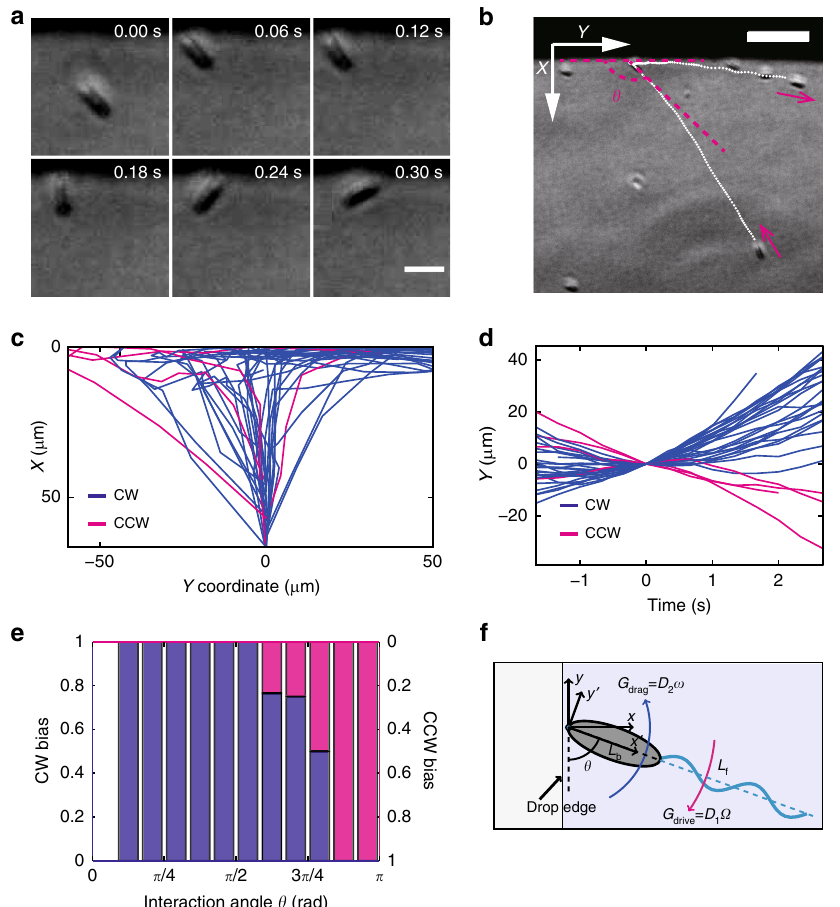
Fig. 3 Single-cell motion pattern of P. mirabilis near diluted colony edge. a A sequence of phase contrast images recording the CW turning of an isolated cell colliding with the diluted colony edge ( “ Methods ” ). The dark area in upper portion of images is virgin agar. Scale bar, 5 μ m. b Trajectory of the cell in panel a generated by overlaying a series of phase contrast images. Magenta arrows by the side of trajectory (white dotted line) indicate instantaneous moving direction of the cell. See Supplementary Movie 8. θ denotes interaction angle, de fi ned as the angle between the diluted colony edge and the cell orientation just before collision. Scale bar, 20 μ m. c Representative trajectories ( N = 31) of cells that collided with diluted colony edge. Following the coordinate system speci fi ed in panel b , X = 0 μ m is set at the edge of liquid drops. The starting point of all trajectories are aligned and set as Y = 0 μ m and X = 55 μ m. Blue (or magenta) lines represent the trajectory of cells that turned CW (or CCW) around the contact point during collision. d Tangential position of cells (whose trajectories were shown in panel e ) plotted against time. The collision positions of all trajectories are aligned and set as Y = 0 μ m, and T = 0 is set at the time of collision. Positive slope at T > 0 indicates that the cell moved in CW sense around the colony after collision. e Probability distribution of cells ’ motion bias after collision with diluted colony edge plotted against interaction angle (Blue column: CW bias; Magenta column: CCW bias). f Model of a swimming bacterium in contact with liquid drop edge (top view). The torque driving reorentation G drive and the drag torque G drag balance, which leads to rotation at a constant angular speed ω about the x = 0; y = 0 point (green dot). The fl agellar bundle is rotating at an angular speed Ω . The length of cell body and fl agellar bundle is L b and L f , respectively. Also see “ Methods